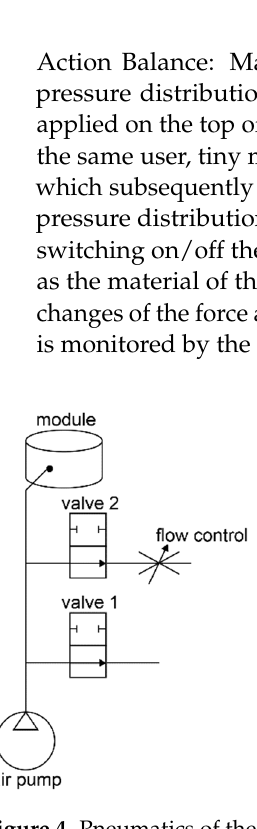
Figure 4. Pneumatics of the module.